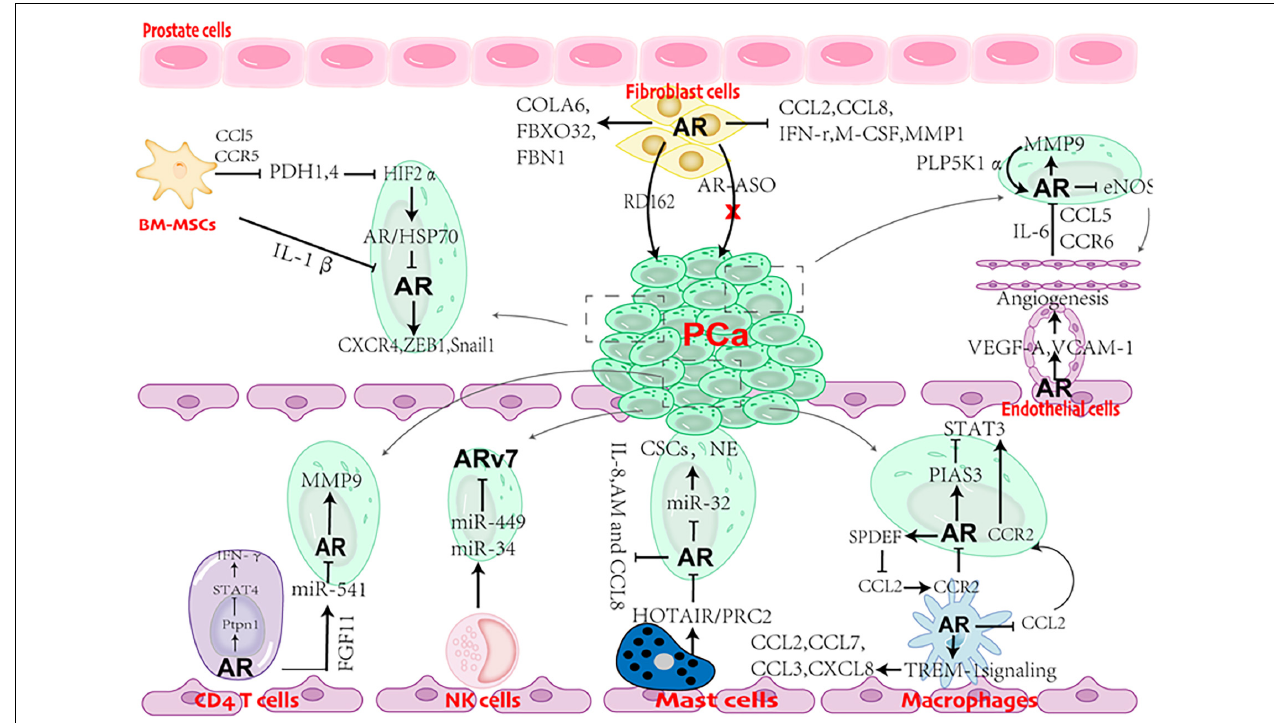
FIGURE 3 | Cartoon showing the role of AR in cross talks between stromal cells and prostate cancer (PCa)